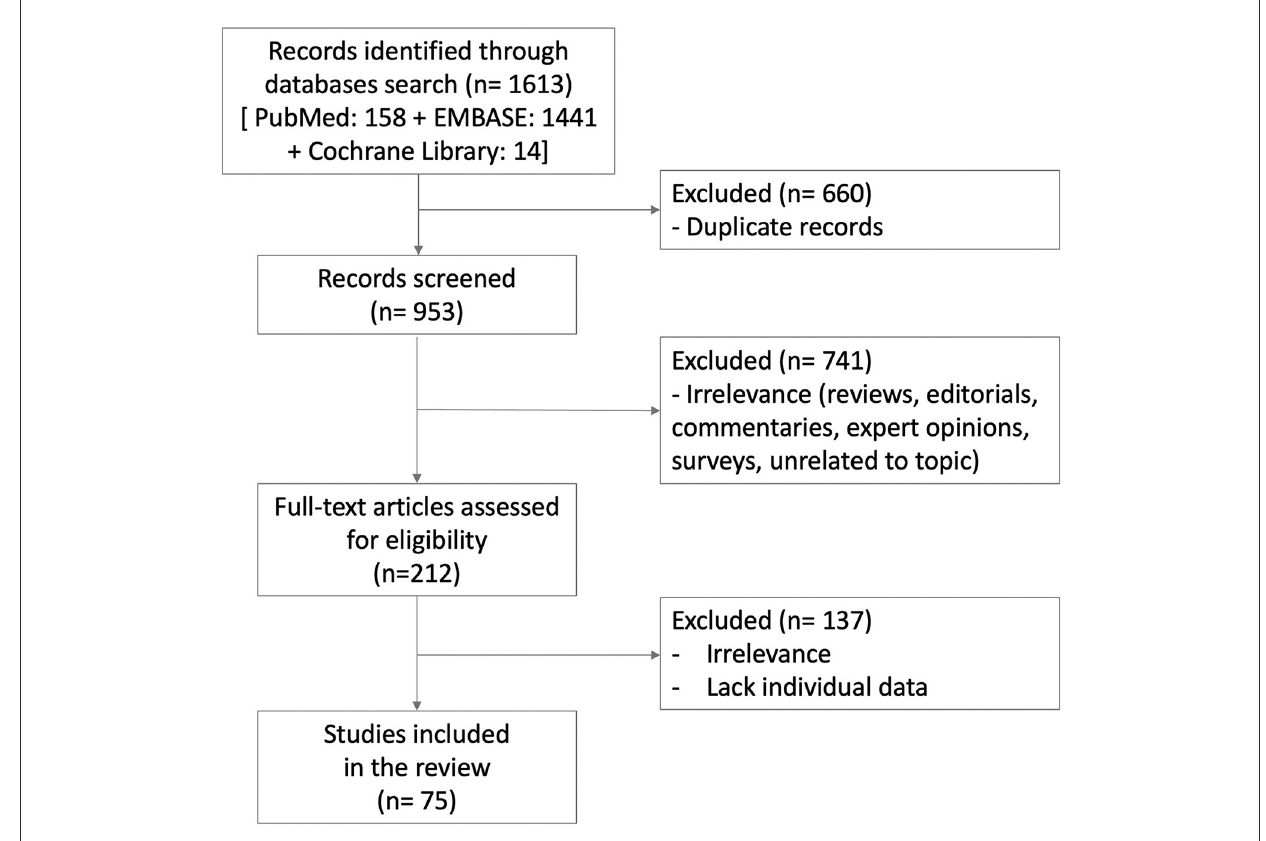
FIGURE1 Flow diagram of the study selection